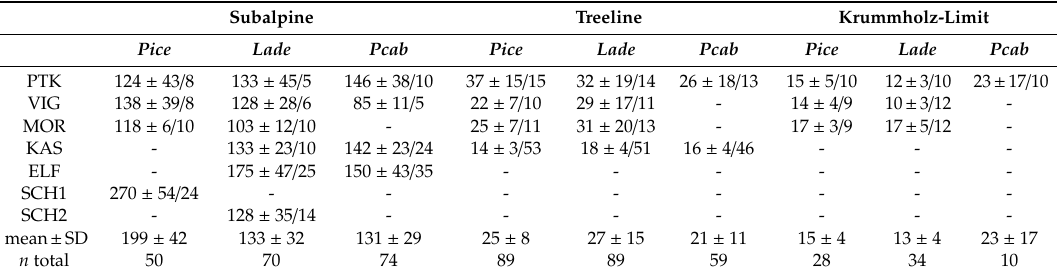
Table 2. Age structure and sample depth of selected stands along elevational transects (mean age (year) ± standard deviation (SD) / n sampled trees). Abbreviations of sites as in Table 1; Pice = Pinus cembra L., Lade = Larix decidua , Pcab = Picea abies L. Karst.